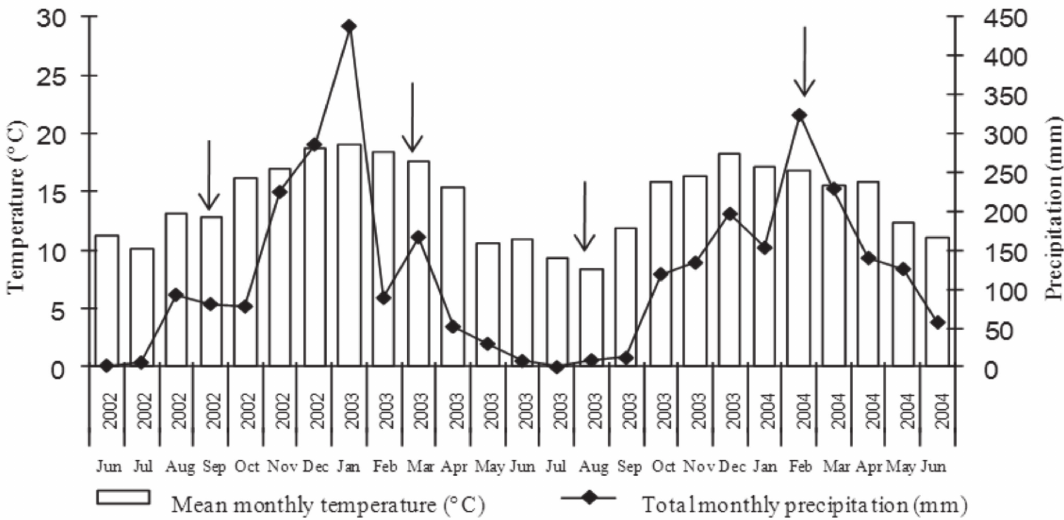
Figure 2. Climate diagram of the areas in the Parque Estadual de Campos do Jordão (PECJ) selected for this study. The arrows indicate the sampling months (September/2002, March 2003, August 2003, and February